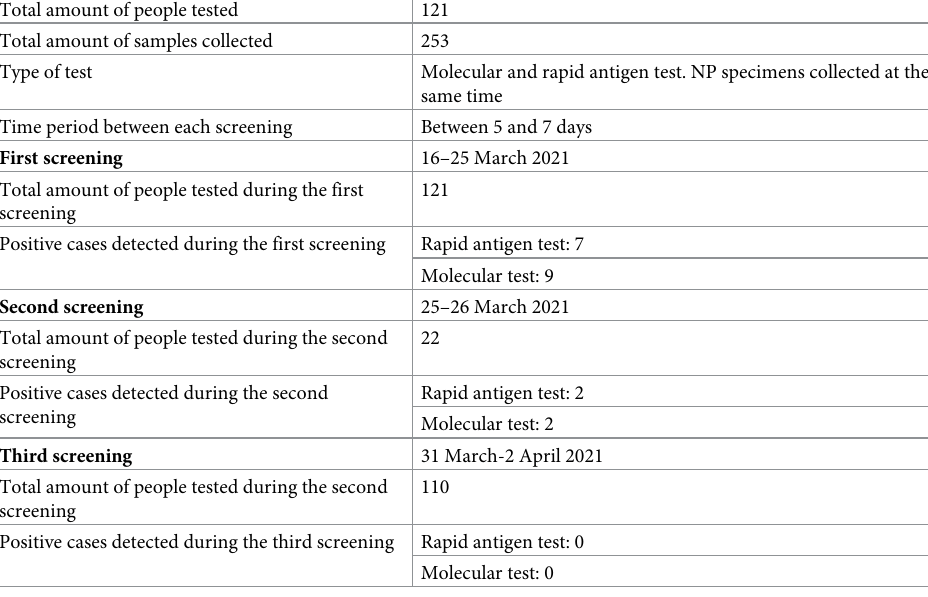
Table 1. Characteristics of the screening adopted by a local manufacturing company to detect SARS-CoV-2 infec- tion between March 16 and April 2,